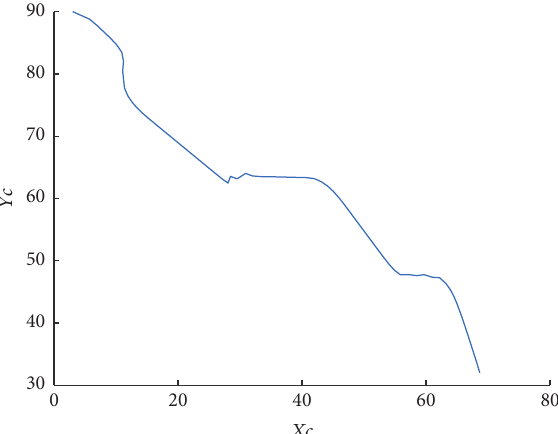
Figure 9: The change of velocity of the OMR controlled by kinematic